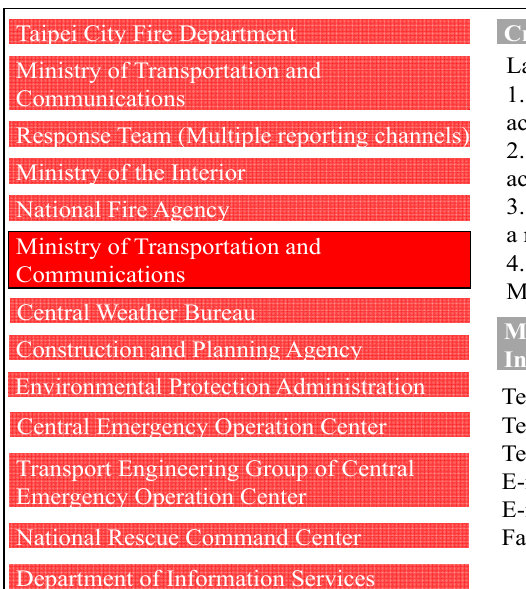
Figure 7. Pre-disaster (usual) preparedness: Equipment inspection. (Source: Research Data). (a) Inspection form; (b) APP; (c) QR Code; (d) Display equipment location.